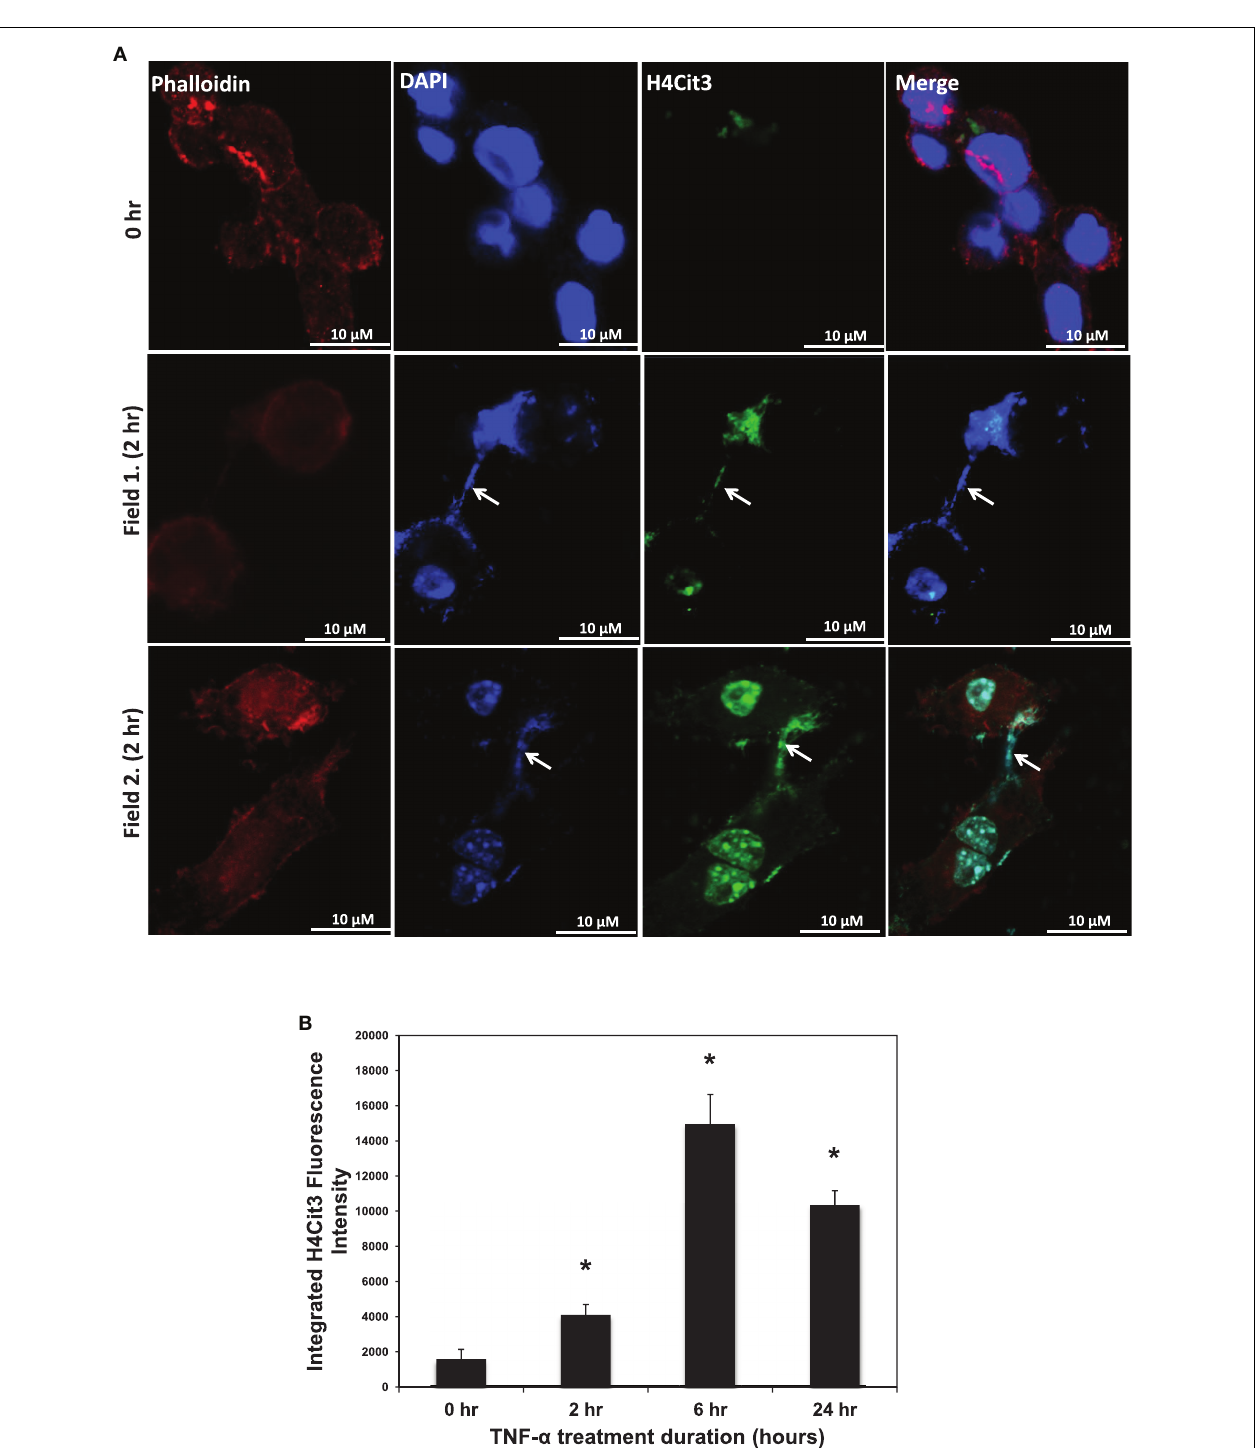
FIGURE 1 | (A) H4Cit3 immunofluorescence staining in RAW 264.7 macrophages following 0 and 2hTNF- α treatment. Cultured RAW 264.7 macrophage cells appear to form METs followingTNF- α stimulation and these METs contain citrullinated histones. DAPI staining (blue) shows that DNA extends beyond the Phalloidin-stained cell borders. Anti-Histone H4Cit3 staining shows presence of citrullinated histones within METs (Arrows).Two separate fields from the 2h treatment group (Fields 1 and 2) are included for reference. (B) Integrated anti-H4Cit3